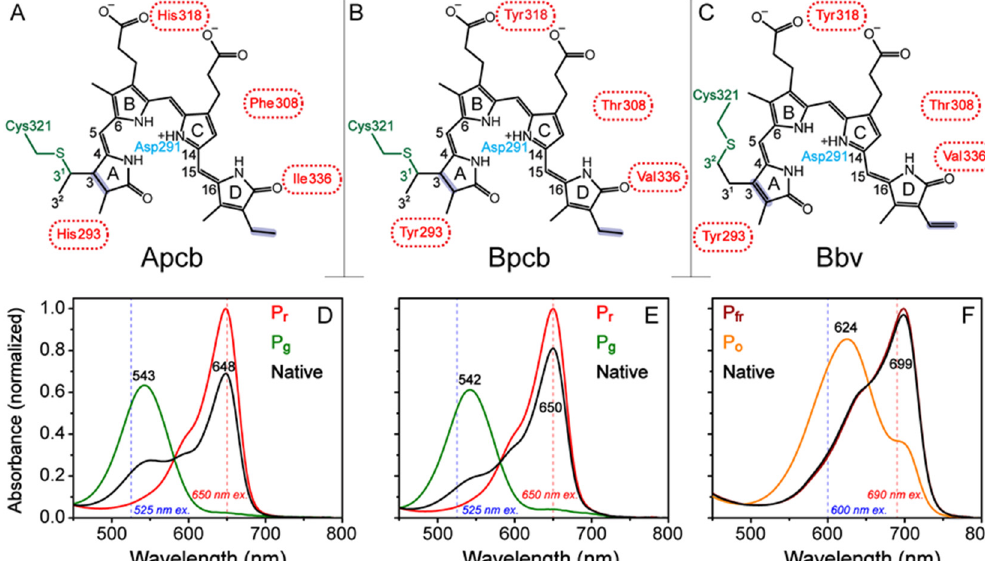
Figure 1. Representative chromophore and surrounding protein residues of ( A ) AnPixJg2_PCB, ( B ) AnPixJg2_BV4_PCB, and ( C ) AnPixJg2_BV4_BV. The associated native/dark-adapted states of 15 Z P r , 15 Z P r , and 15 Z P fr are depicted. Four residues responsible for the BV incorporation are shown (red) with Cys321 (green) that covalently binds cofactor to protein pocket. Key changes to cofactor conjugation are highlighted by purple shades with Asp291 (cyan) as an important H-bonding partner to A, B, and C rings. The absorption spectra of ( D ) Apcb, ( E ) Bpcb, and ( F ) Bbv are normalized to the reddest- absorbing species. Sample spectra were collected after ambient light, 505 nm LED, 650 nm LED, 600 nm LED, and a tungsten lamp with 650 nm longpass filter irradiation for 5 min for the native (black), P r (red), P g (green), P fr (dark red), and P o (orange) species, respectively. The actinic pump wavelengths for fs-TA experiments are labeled by vertical dashed blue and red lines in each panel.